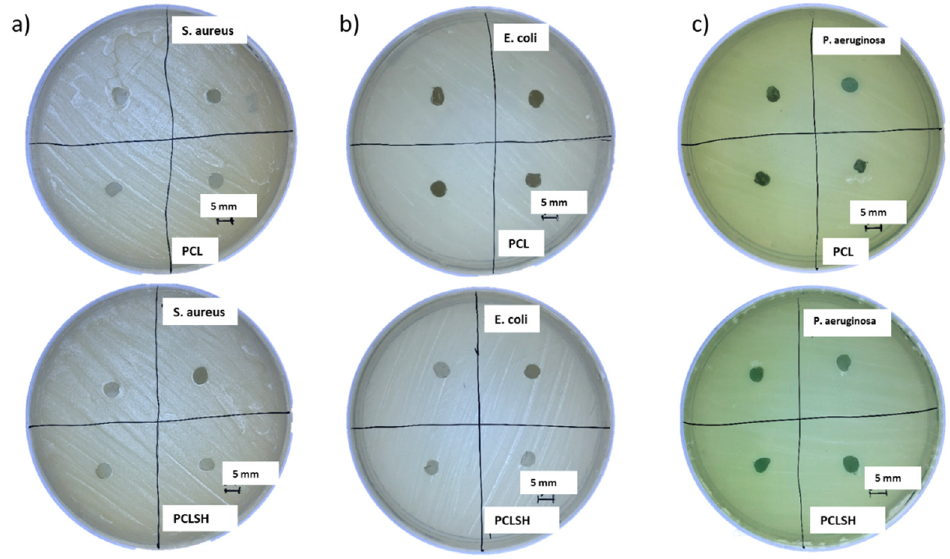
Figure 9. Inhibition zone of PCL ( top ) and PCLSH30 ( bottom ) electrospun meshes on agar plates using the disk diffusion method. ( a ) S. aureus , ( b ) E. coli , and ( c ) P. aeruginosa (scale = 5 mm).